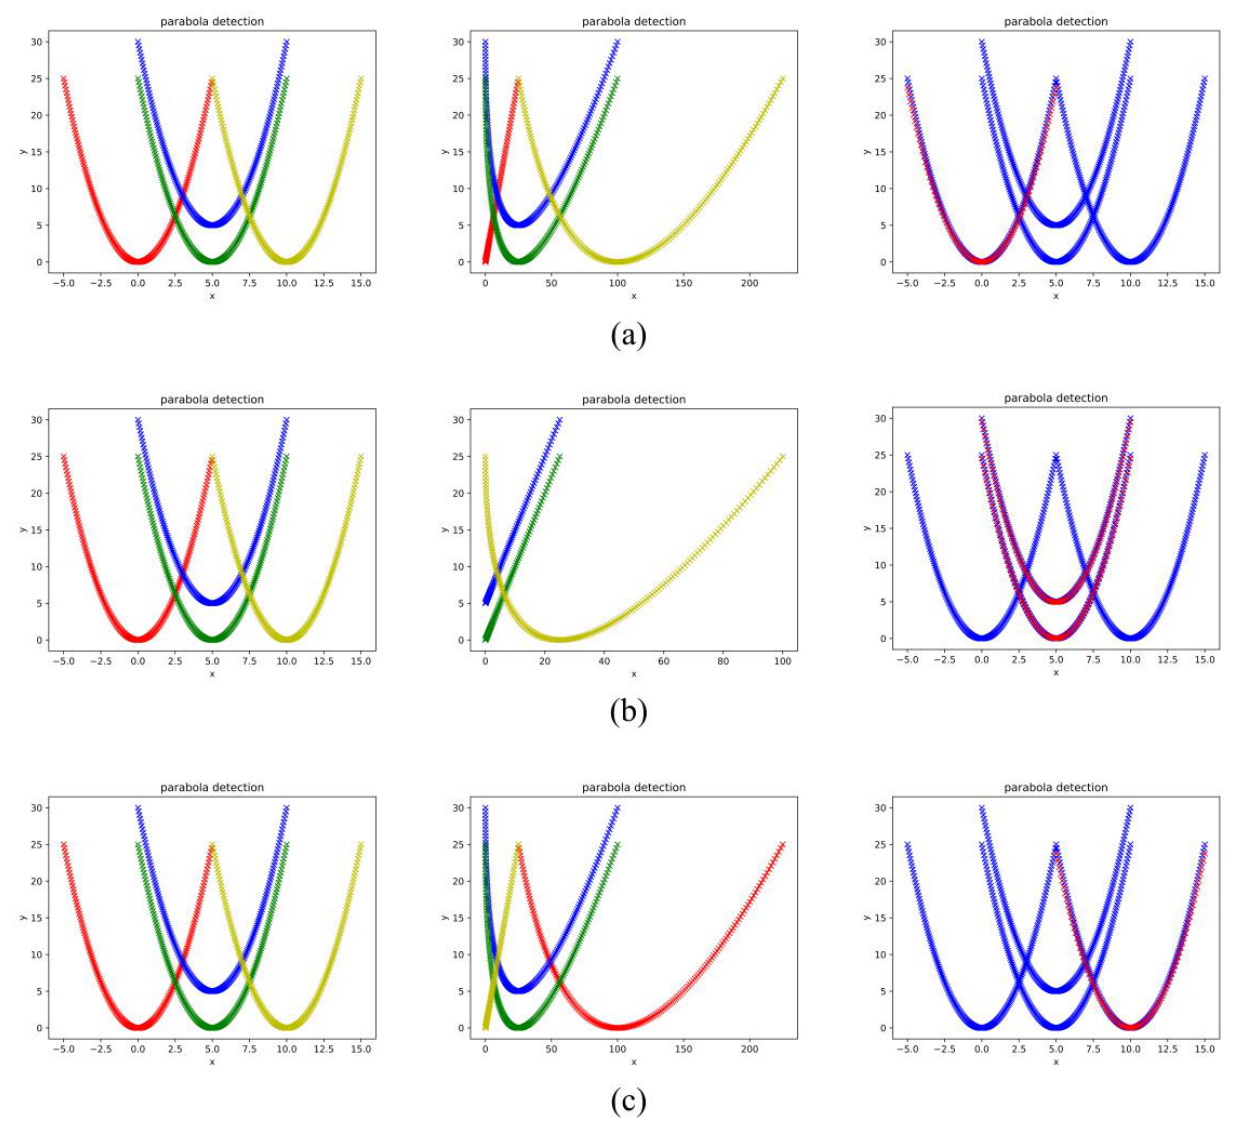
Figure 9. Parabola recognition with Hough transform after coordinating transformation. ( a ) Result for parabola recognition when 𝑎 2 = 0 . ( b ) Result for parabola recognition when 𝑎 2 = 5 . ( c ) Result for parabola recognition when 𝑎 2 = 10 .